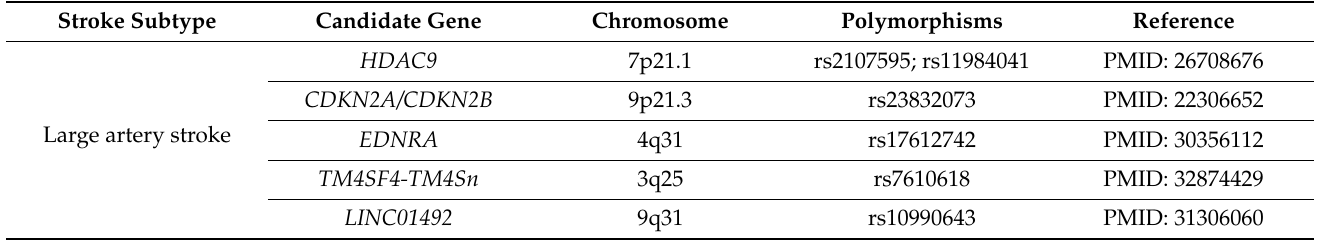
Table A1. Genes contributing to polygenic risk of the ischemic